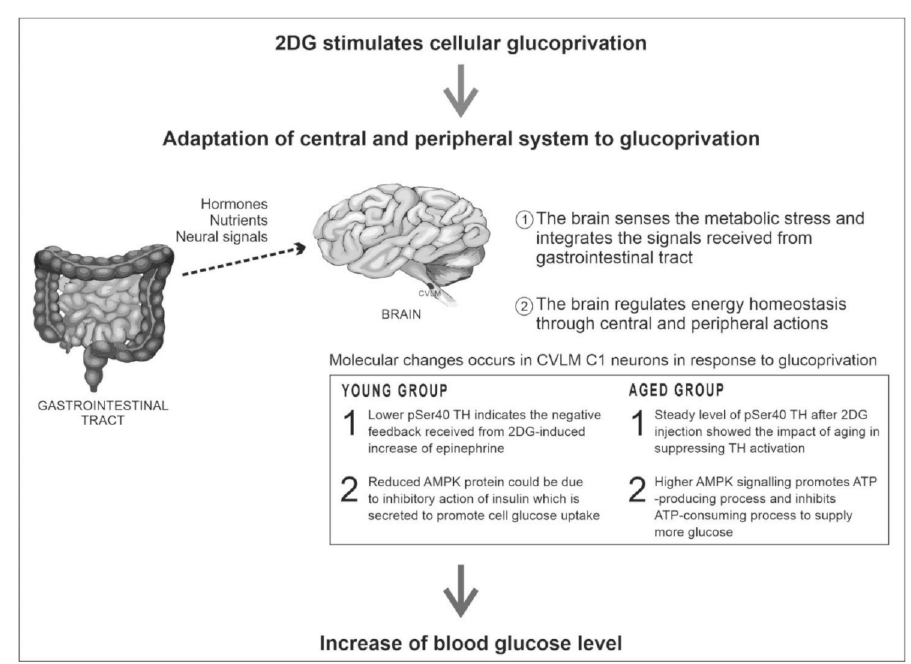
Figure 4. Summary of the glucose counterregulatory responses in CVLM neurons following glucopri- vation in young and aged rats